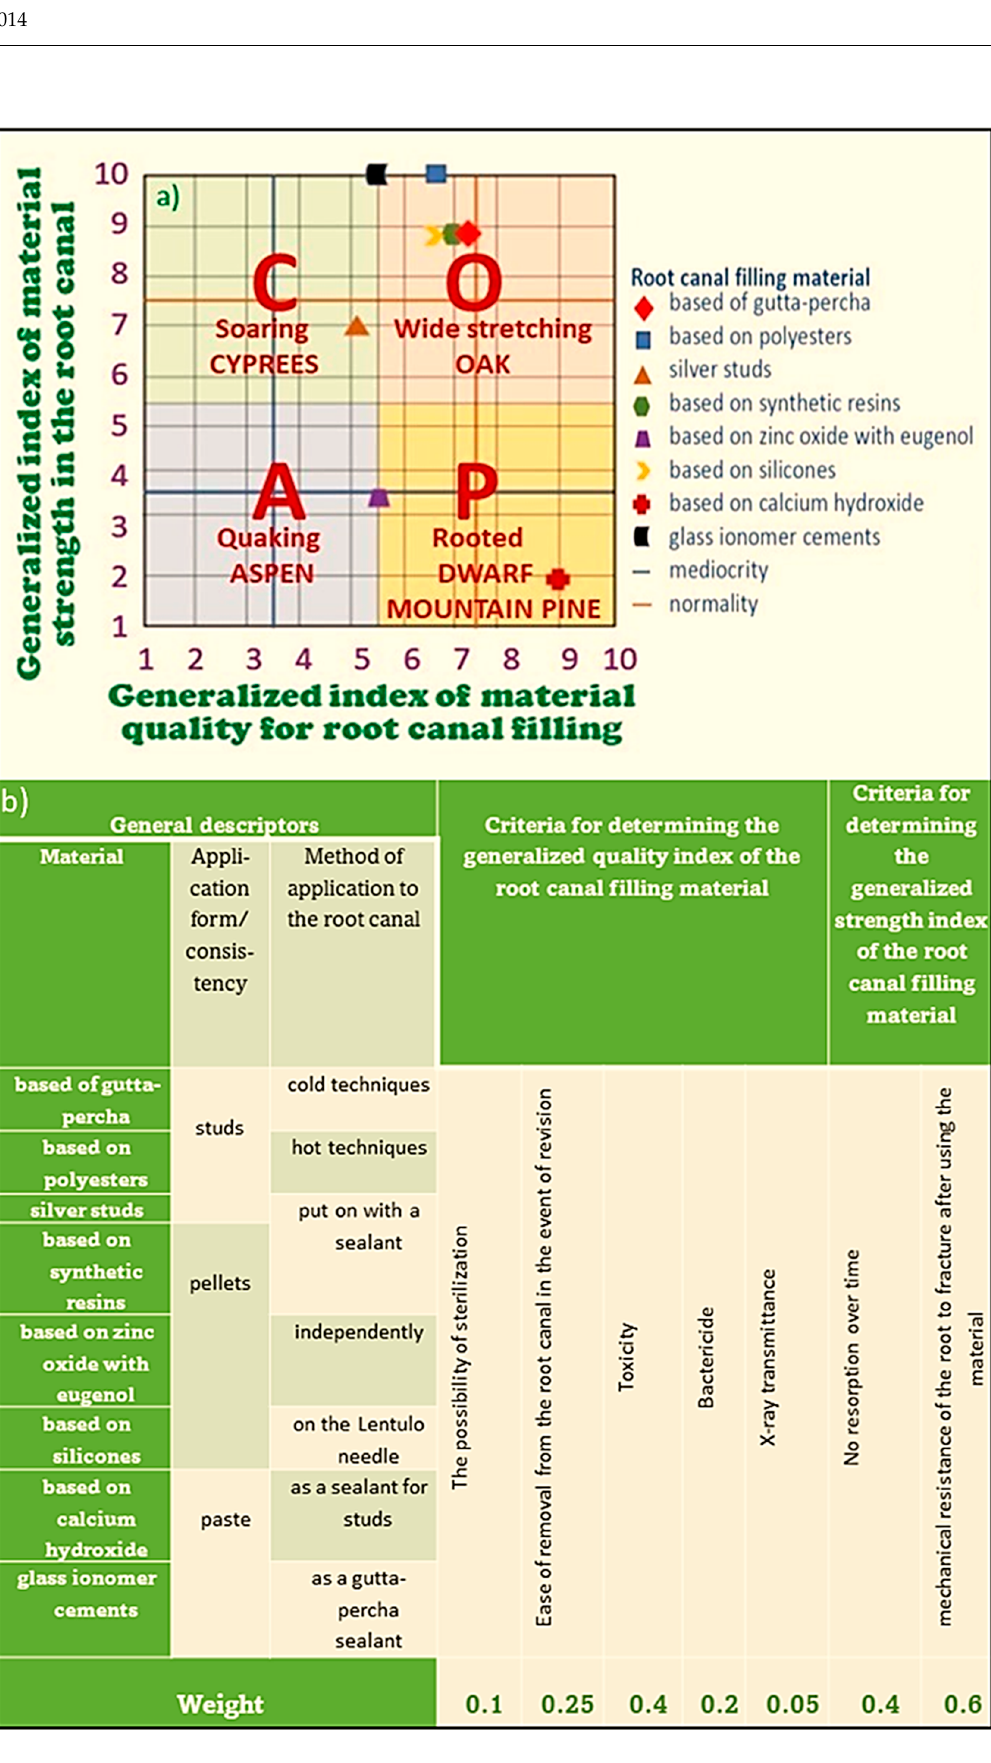
Figure 31. Contextual matrix of attractiveness ( a ) of virtual contextual analysis concerning the selection of root canal filling material and a set of adopted evaluation criteria ( b ).